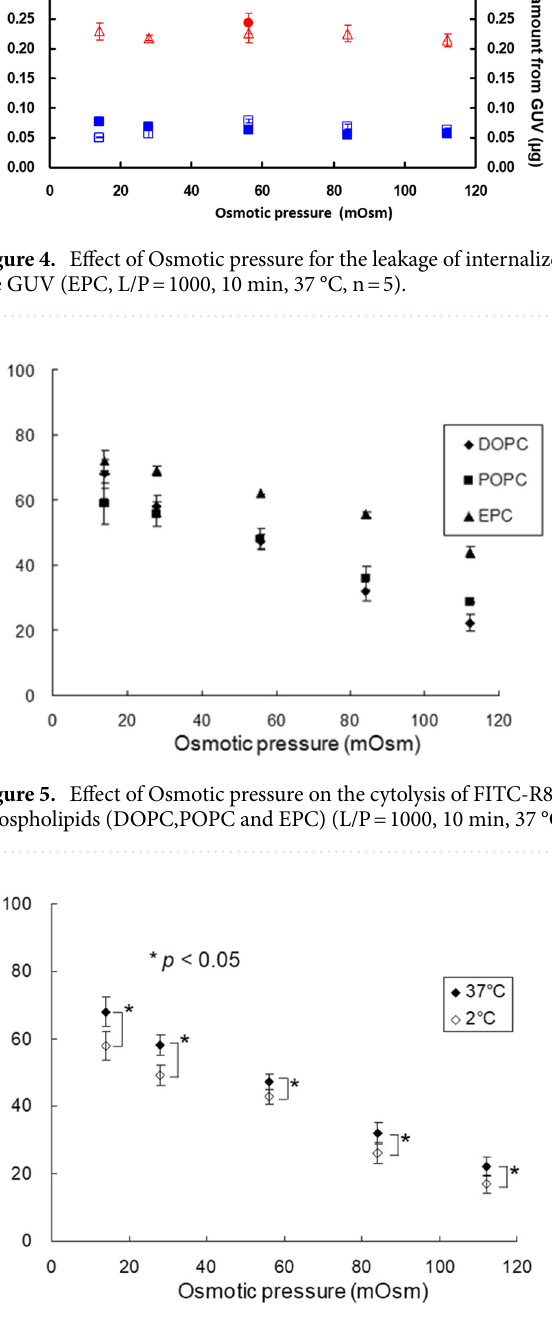
Figure 6. Effect of temperature on the cytolysis of FITC-R8 into EPC GUV under osmotic pressure change (L/P = 1000, 10 min, at 2 or 37 °C, n = 5, Significant differences were obtained using